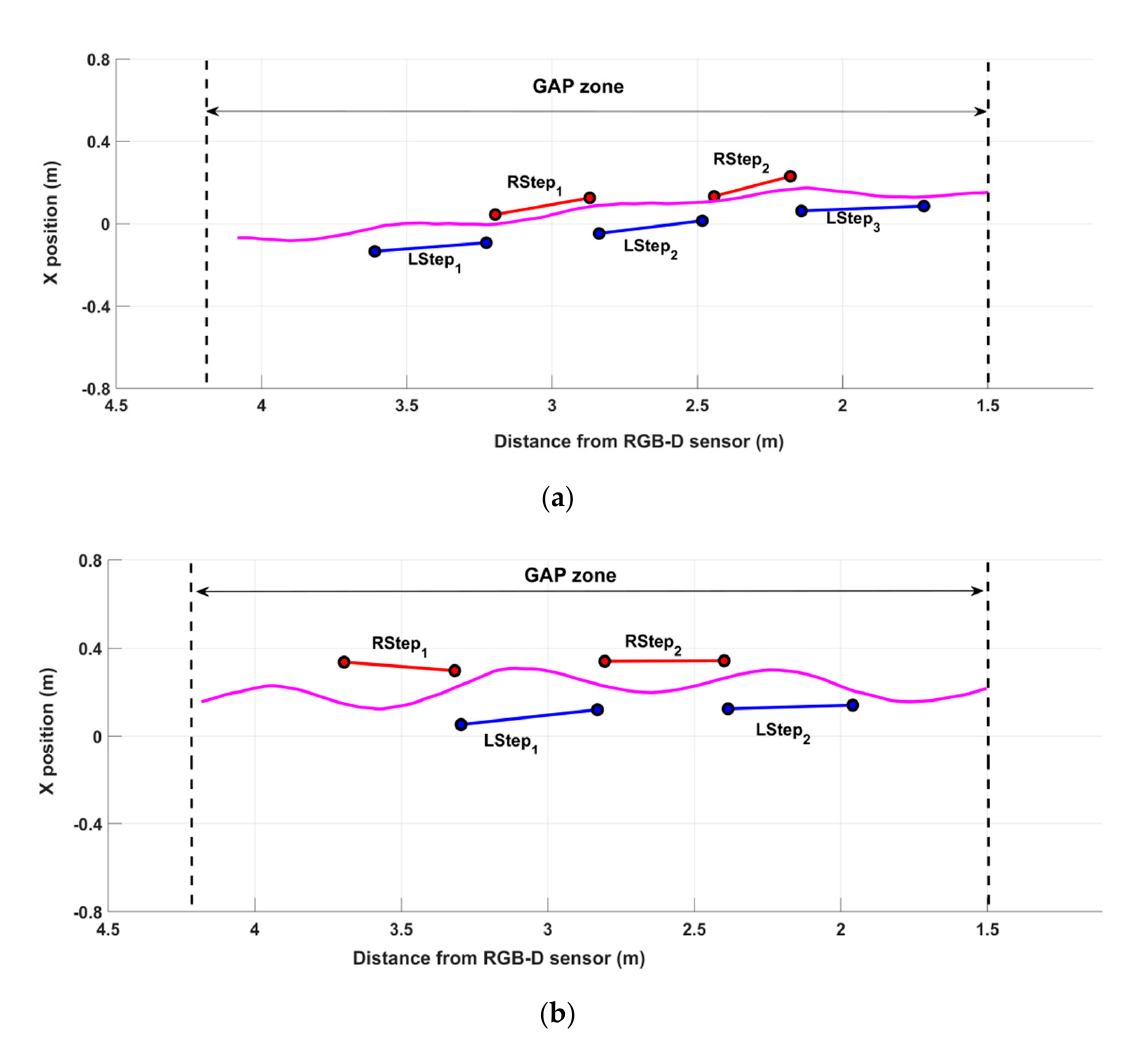
Figure 4. Gait patterns of one PD ( a ) and one post-stroke ( b ) participant. The black dotted lines delimit the GAP zone. The x -axis represents the 3D distance of the subject from the RGB-D sensor, while the y -axis represents the position relative to the sensor’s x -axis. The magenta lines represent the trajectory of COM HIP . Table 2. Spatio-temporal and COM parameters for the left and right sides of PD and PS performance shown in Figure